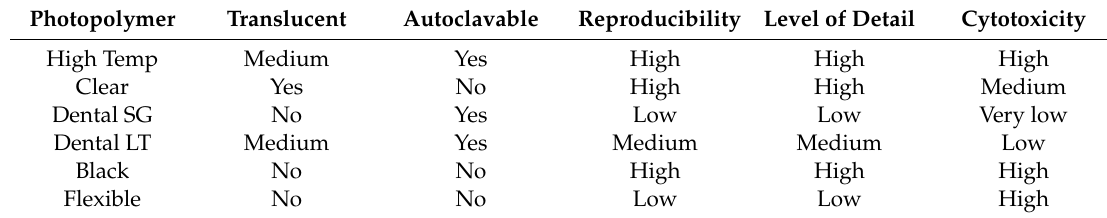
Table 2. Summary of material and cytotoxicity testing of